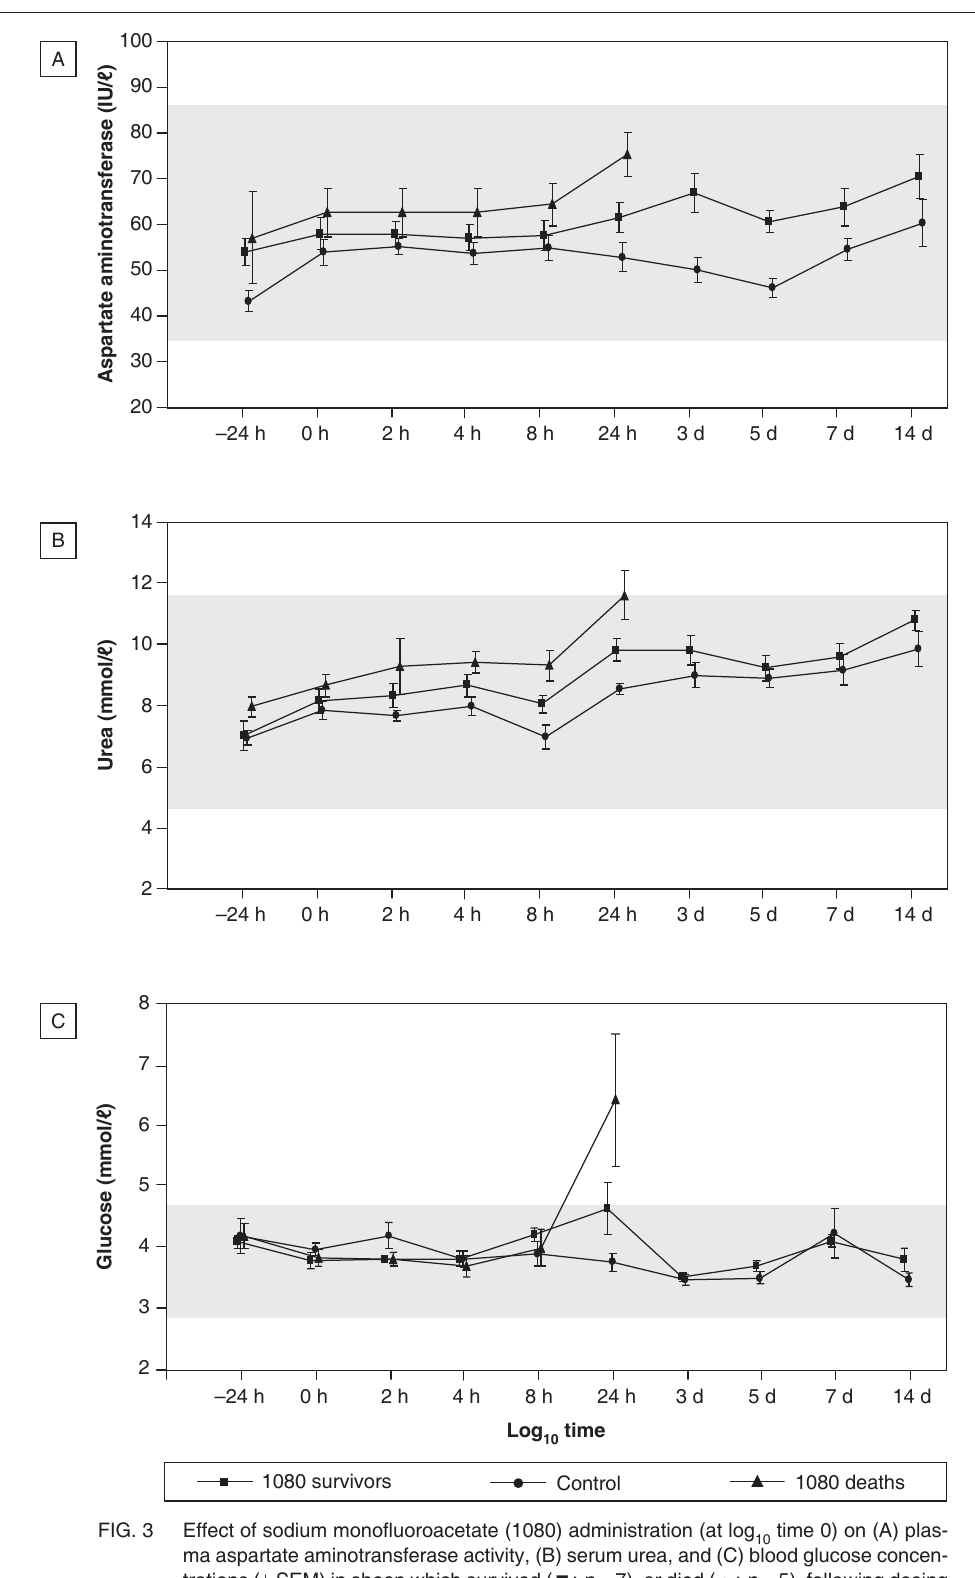
FIG. 3 Effect of sodium monofluoroacetate (1080) administration (at log ma aspartate aminotransferase activity, (B) serum urea, and (C) blood glucose concen- trations ( ± SEM) in sheep which survived ( (cid:31) ; n = 7), or died ( (cid:24) ; n = 5), following dosing with 0.30 mg sodium monofluoroacetate (1080) per kg, and in control sheep ( (cid:32) ; n = 8), from − 24 h to Day 14 after exposure (Experiment 1). The shaded areas denote the normal